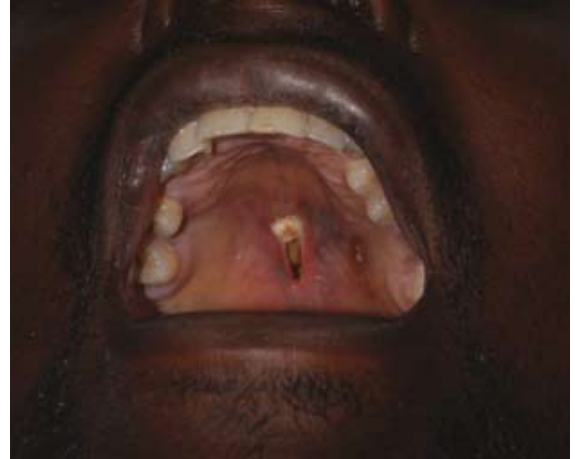
Fig. 1. Perforation of hard